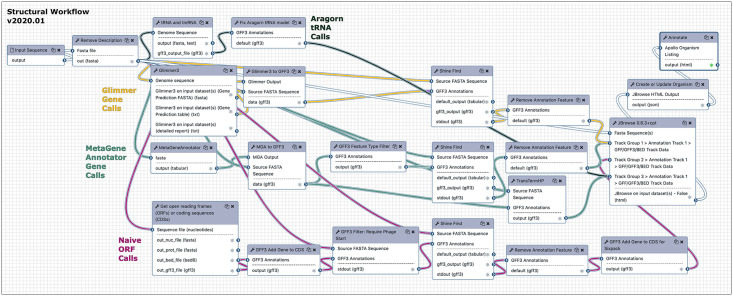
The structural workflow chains together tools in Galaxy for gene calling.The structural workflow accepts as input a nucleotide FASTA genome sequence, and processes it through ARAGORN for tRNAs (dark noodles), Glimmer and MetaGeneAnnotator for high-confidence gene predictions (golden and teal, respectively), and Get ORFs as a naïve ORF/CDS caller (magenta). Potential protein-coding genes are filtered to ensure the presence of a phage (ATG/GTG or TTG) start codon and a Shine-Dalgarno feature is added to all features that have a detectable match. These are interconverted between formats and the gene models are corrected for display in Apollo.